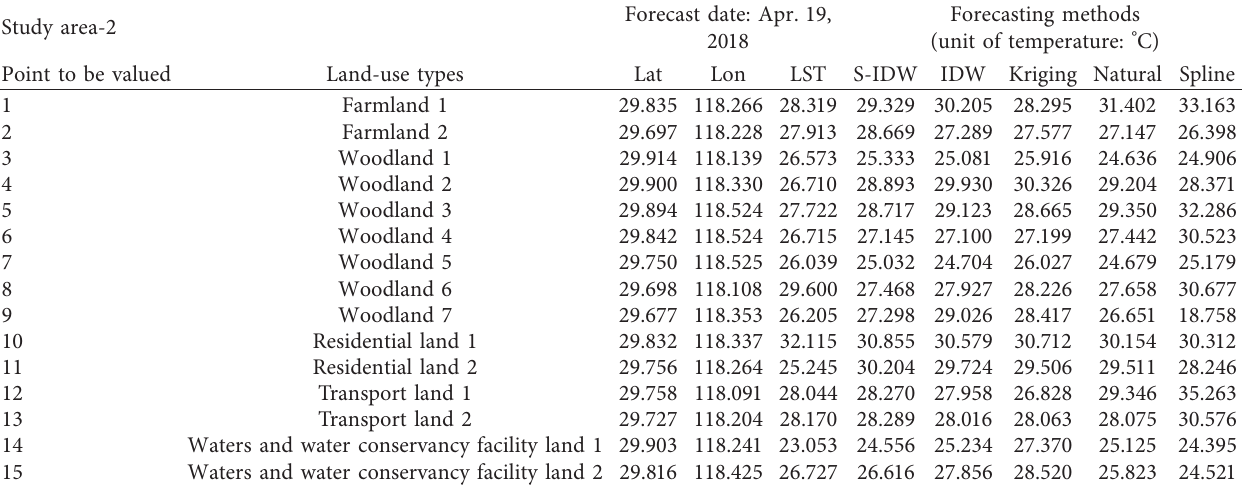
∗∗ Significant correlation at 0.01 level (two-tailed). Table 15: Comparison of interpolation results of 5 kinds of interpolation methods on Apr. 19, 2018.